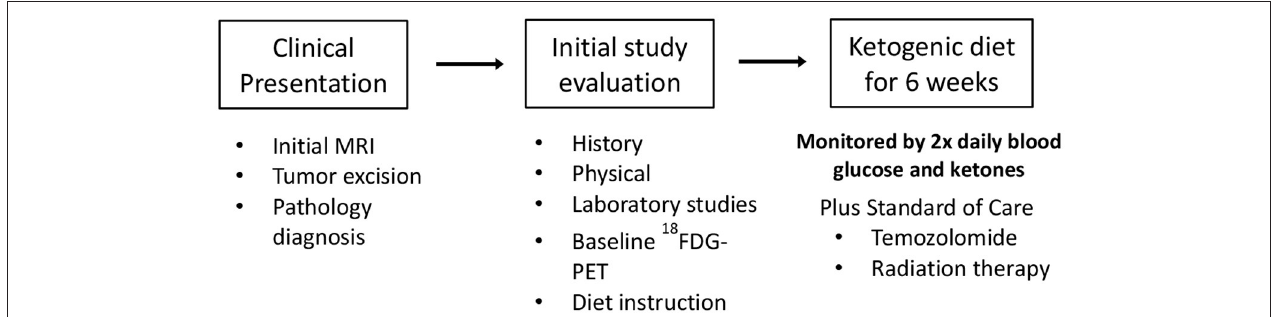
FIGURE 1 | Schematic of the ketogenic diet